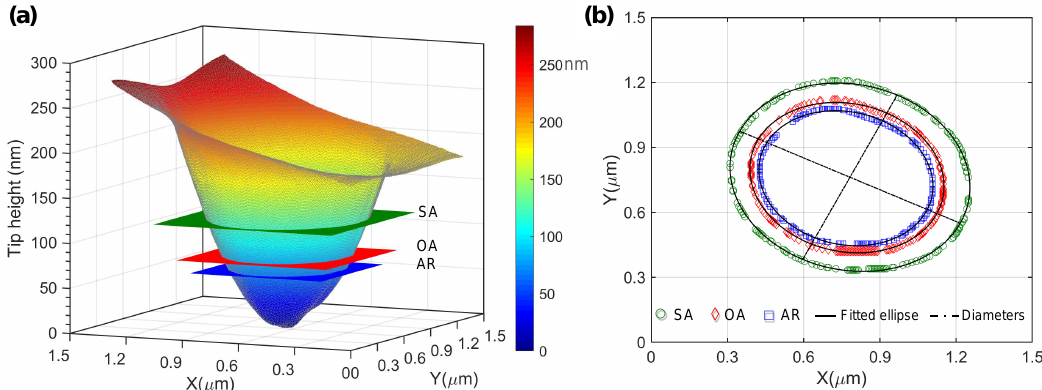
Figure 2. ( a ) The 3D conical tip topography obtained by reverse imaging. The three planes crossing the tip show a representative h c for the SA, OA, and AR samples obtained from the nanoindentation L-D curves. ( b ) The cross-sectional top view of the three mentioned planes fit with an elliptical